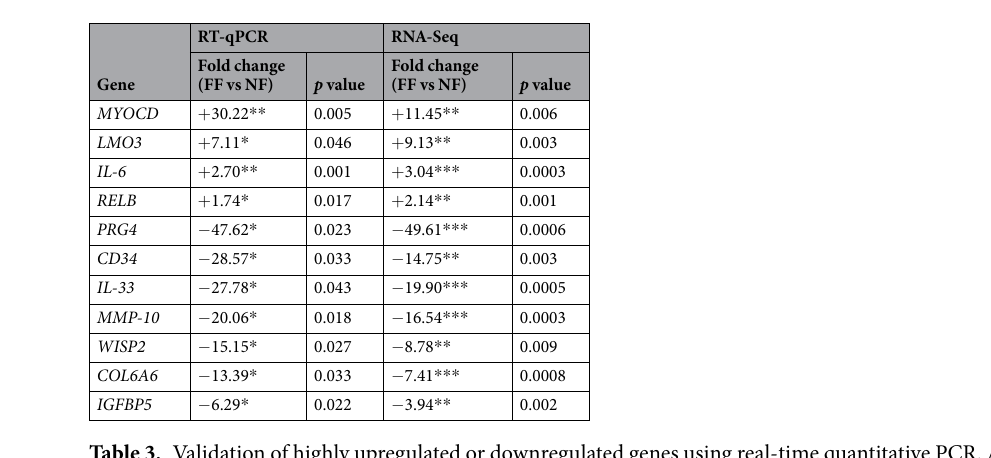
Table 3. Validation of highly upregulated or downregulated genes using real-time quantitative PCR. All mRNA values were normalised relative to that of GAPDH and triplicate experiments were performed for each gene. Statistically significant differences were expressed as * p < 0.05; ** p < 0.01; *** p <